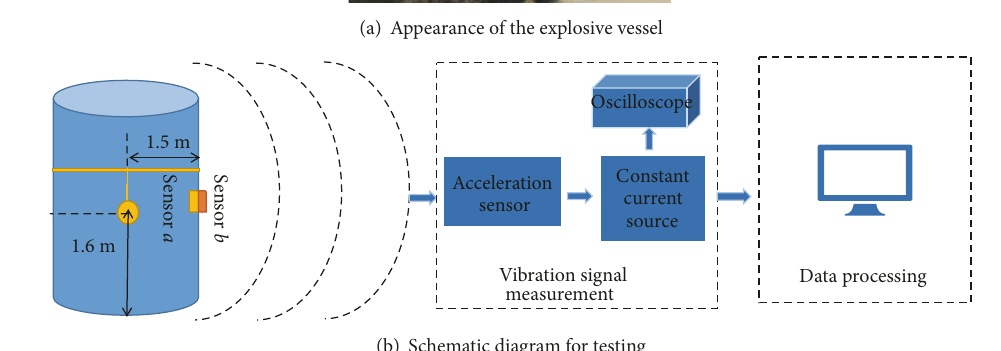
Figure 2: Experiment system.